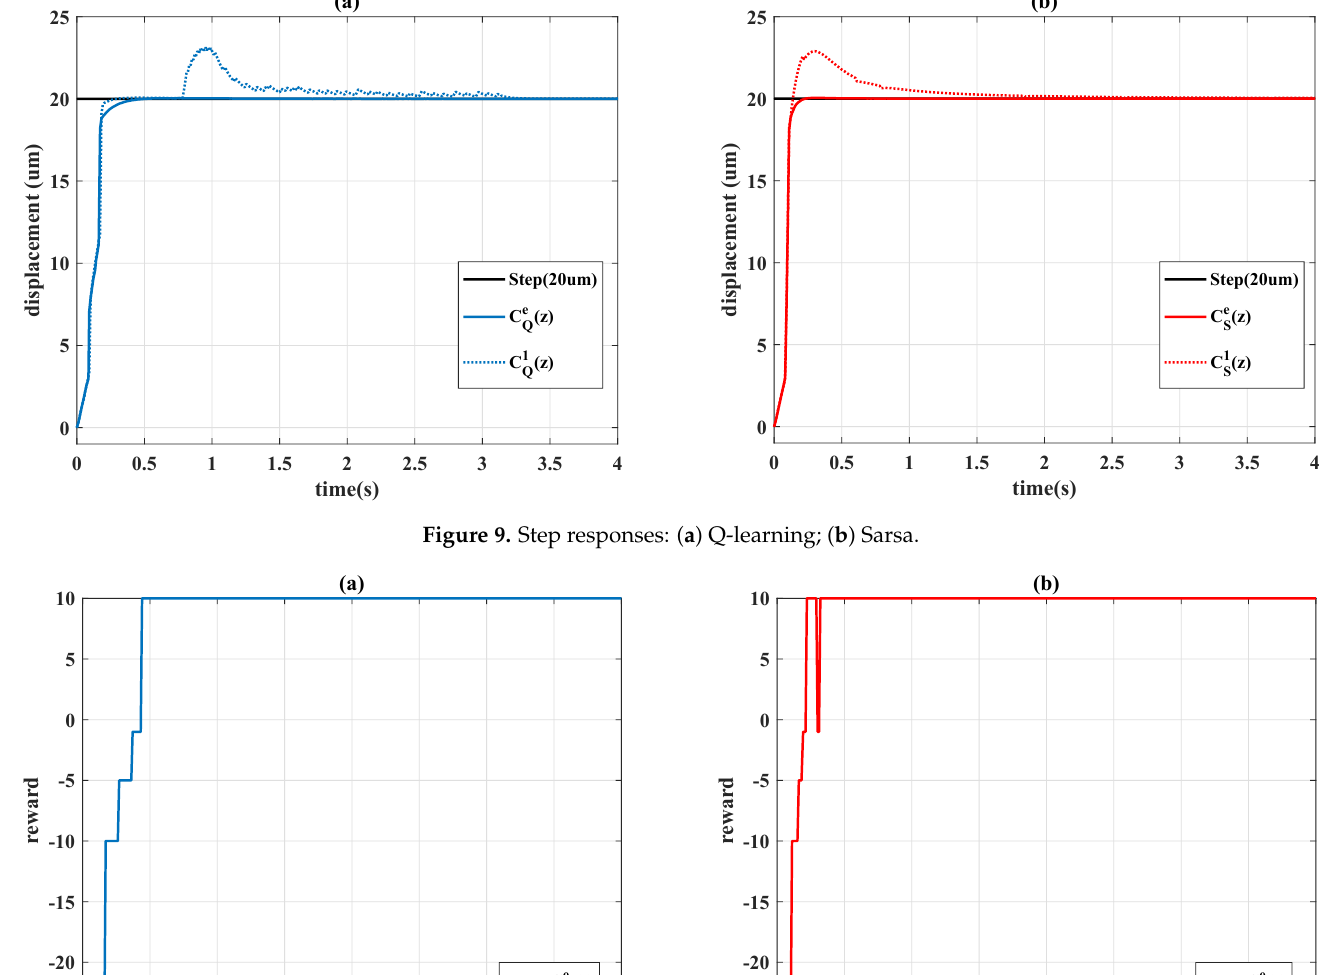
( z ) ; ( b ) Sarsa C e ( z ) Q S